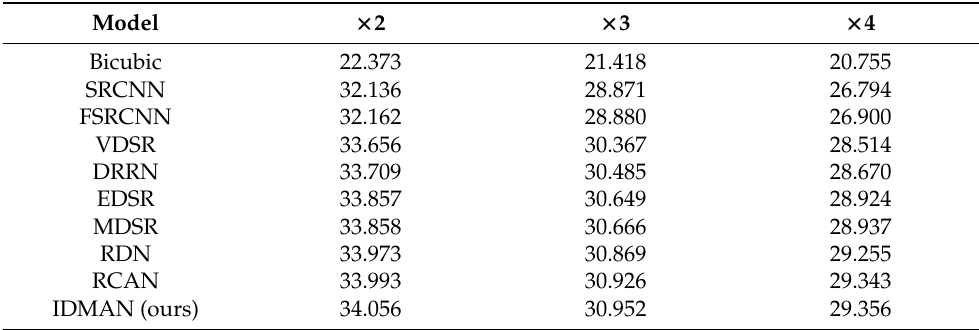
Table 5. The average PSNR (dB) results of different algorithms on the DeepLesion testing set with different scaling factors.